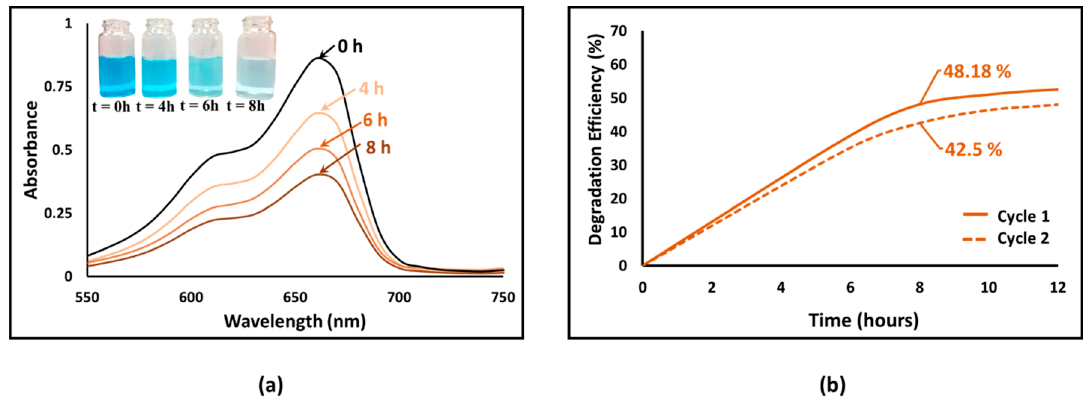
Figure 9. ( a ) Absorption spectra (inset: actual dye intensity in water solution) and ( b ) the corresponding % efficiency of MB degradation for first and second (reusability) cycles of MB solution degradation at varying exposure times to TiO 2 -coated GP spheres.